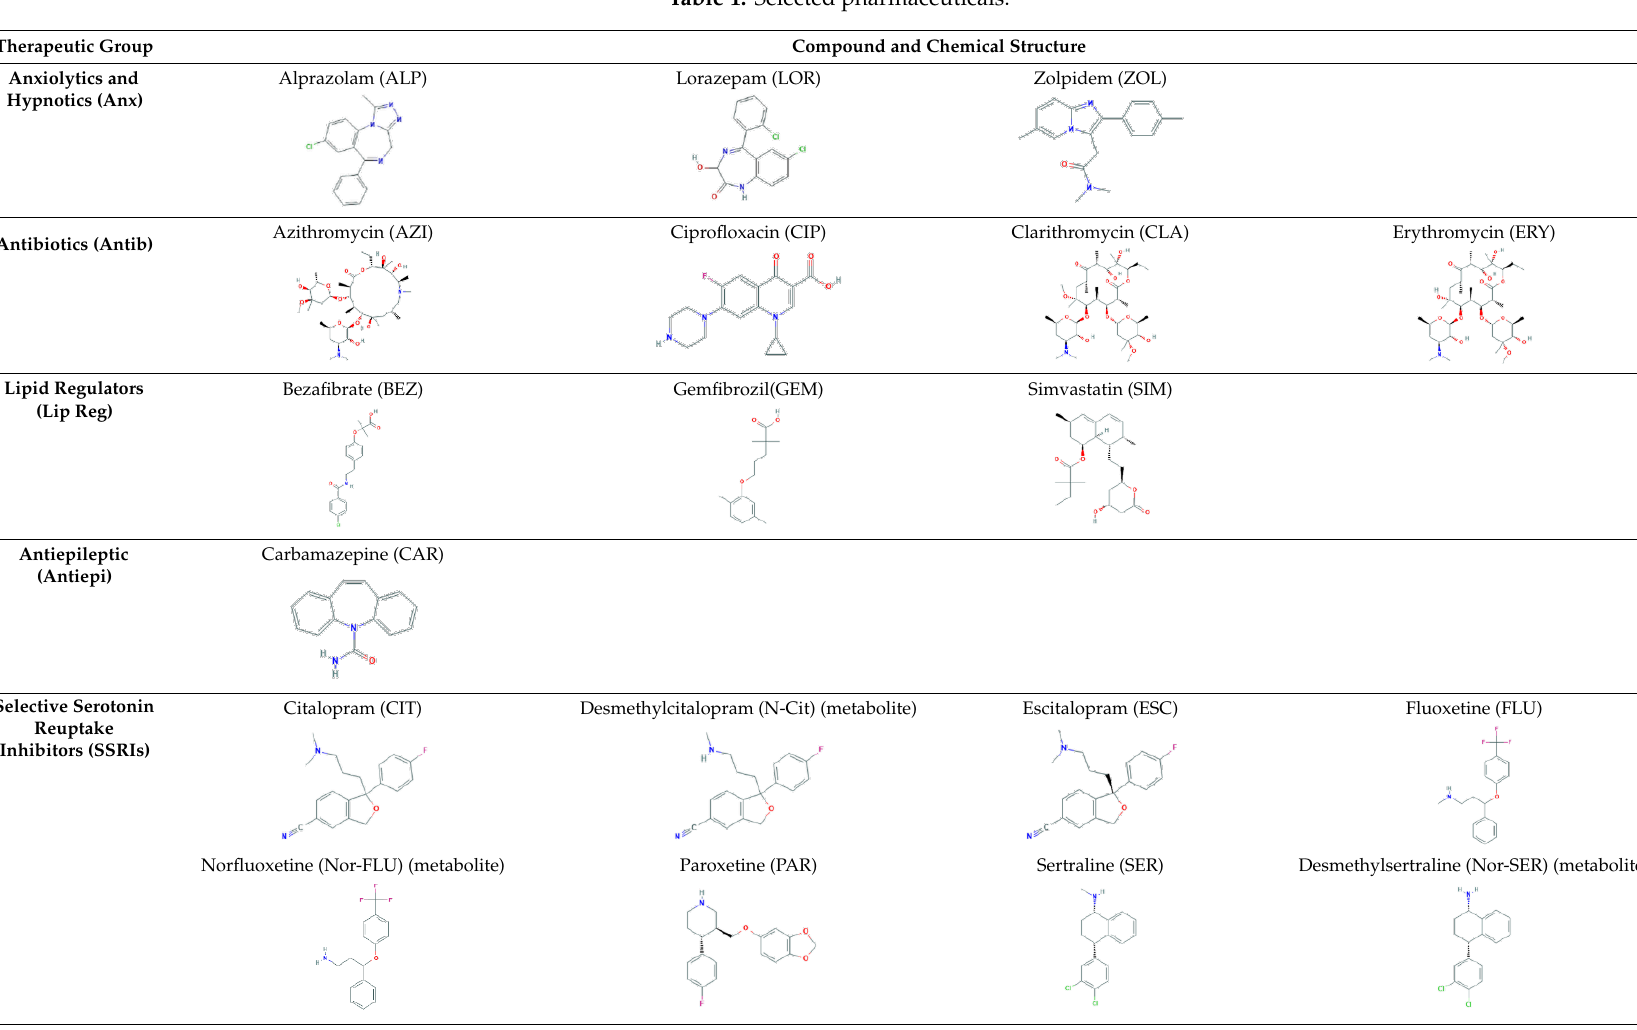
Table 1. Selected